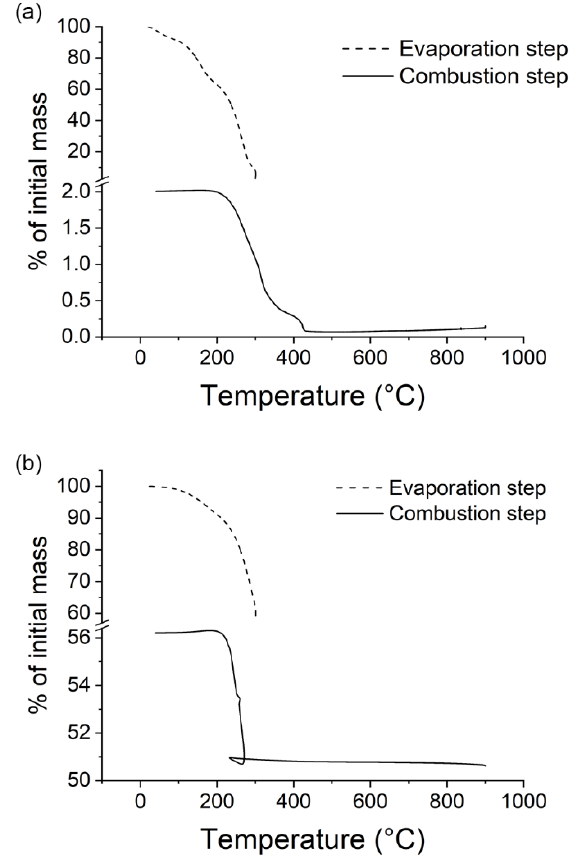
Figure 4. Thermogravimetric analysis ( TGA) thermograms of ( a ) the product of experiment at 250 °C, ( b ) the spent Ru/ZrO 2 (250 °C) catalyst soaked in product. Note the scale breaks . Table 1. Summary of the characterization results from X-ray fluorescence (XRF), physisorption, and chemisorption.